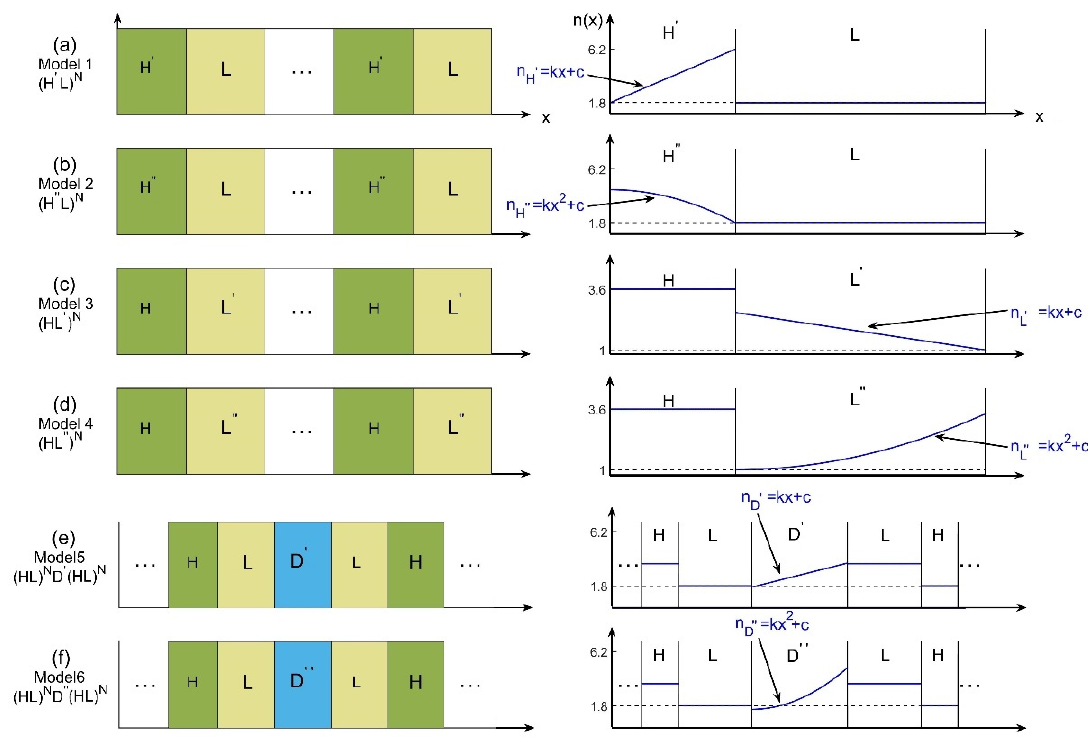
Figure 1. Schematics and distributions of refractive index for Models 1–6 from ( a – f ). Models 1–4 are the complete 1D GPCs for the research of PBG, and Models 5–6 are the defective 1D GPCs for the research of defect mode.